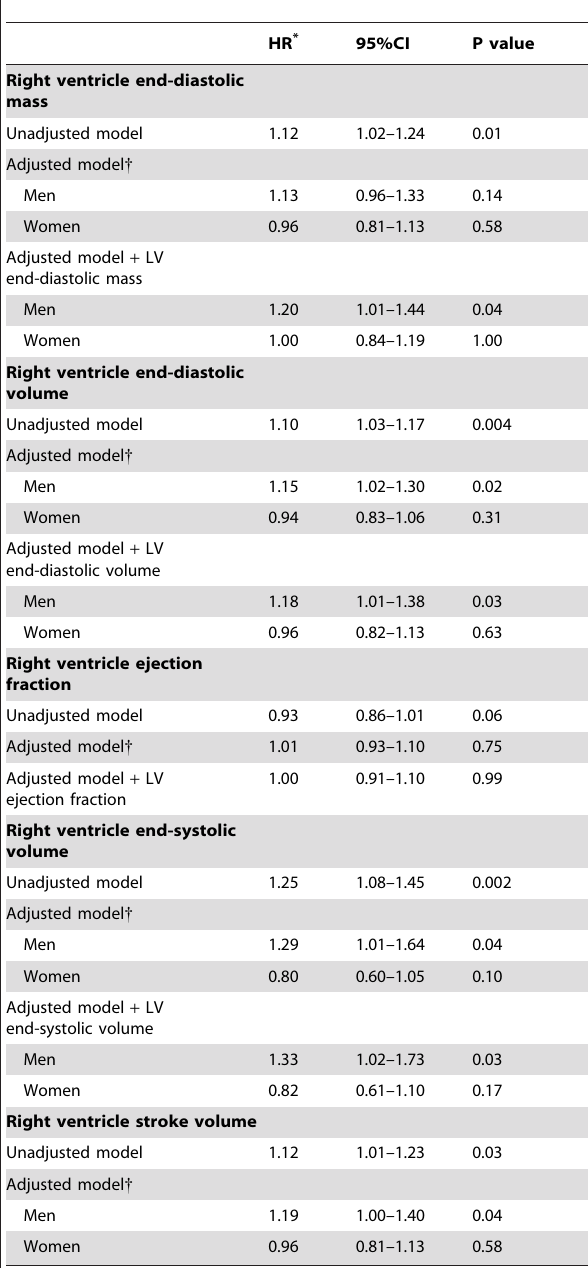
Table 5. Cox proportional hazards models for RV measures and time to dyspnea in participants with available lung